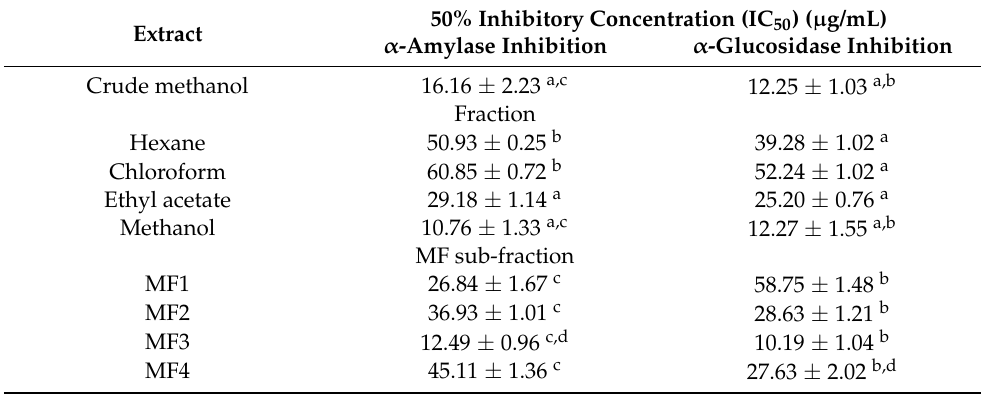
Table 2. α -amylase and α -glucosidase inhibition activity of crude extract and fractions. 50% Inhibitory Concentration (IC 50 ) ( µ Extract